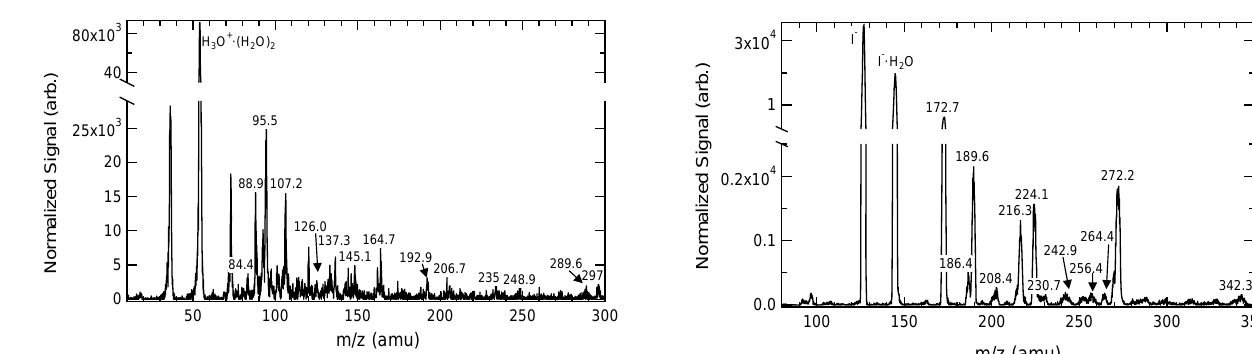
Figure 7. Aerosol-CIMS spectra of atomized solutions of 0.5 M acetaldehyde/MG